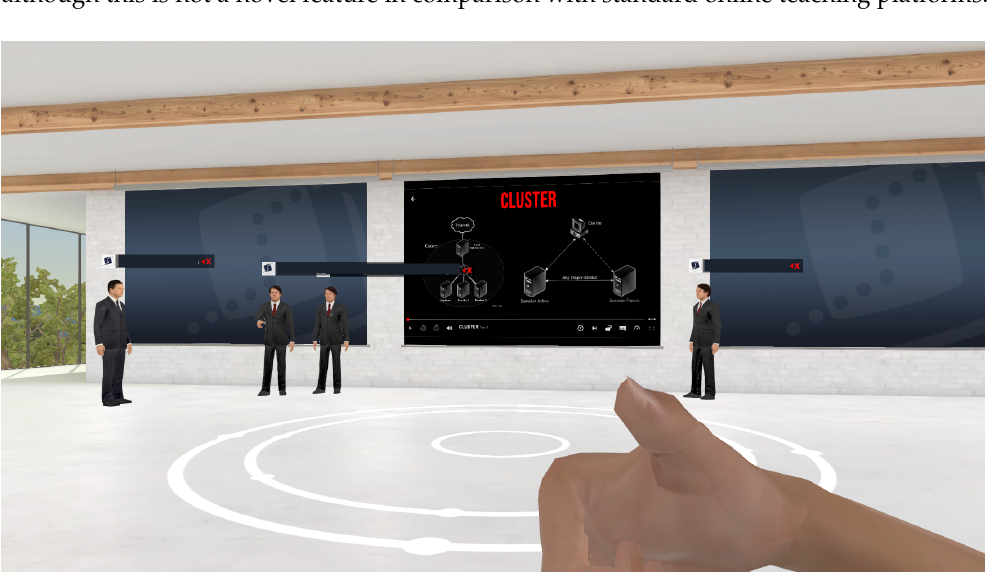
Figure 10. Thumbs-up to students from the teacher’s perspective in LearnSpace.